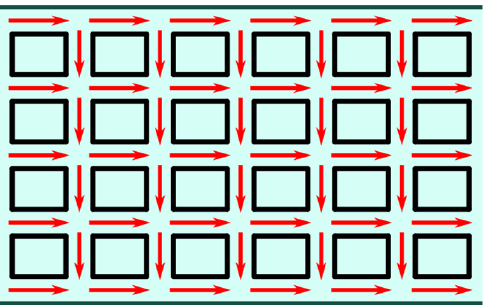
Figure 9. Rectangular microfeatures of a flat heat exchanger used in direct winding cooling.